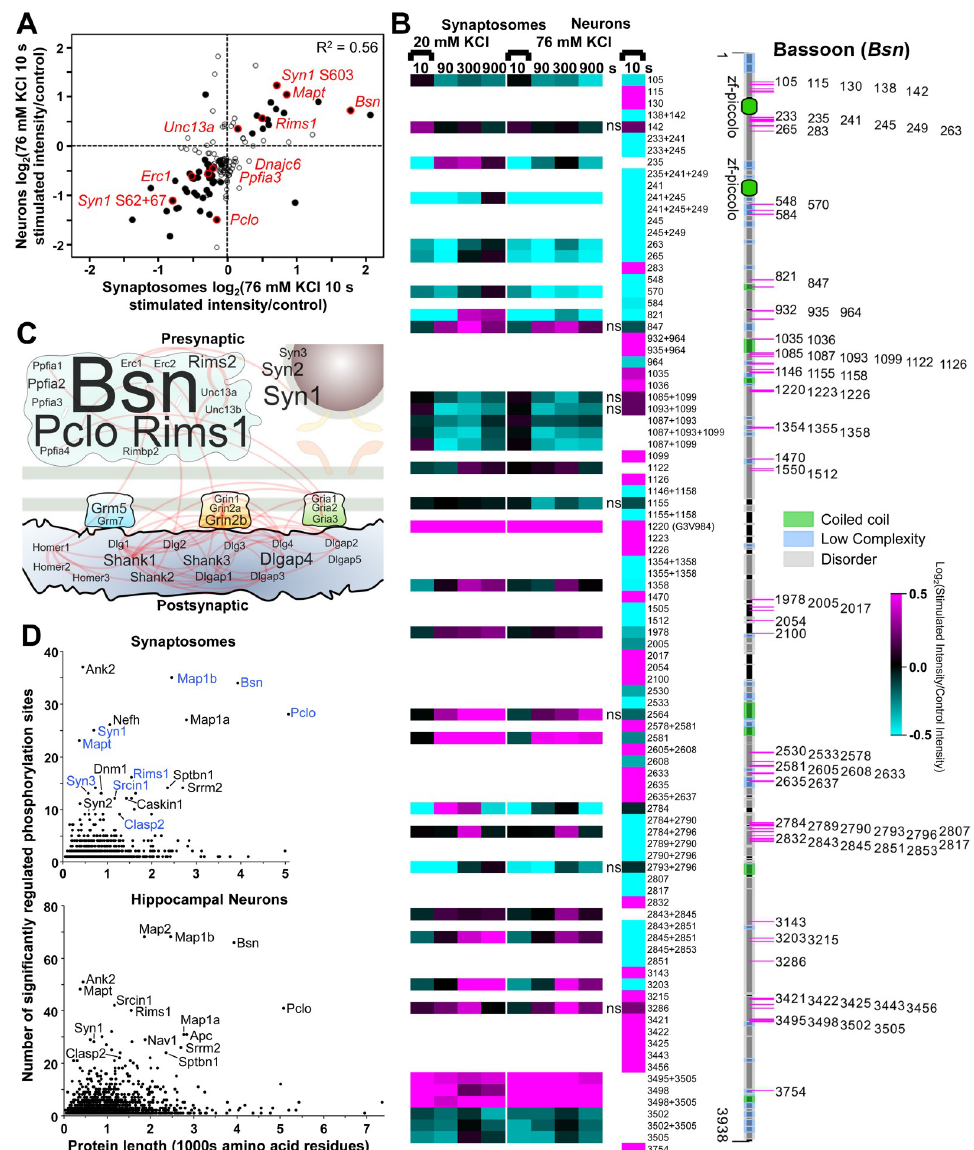
Fig 2. Comparison of activity-dependent changes in synaptosomes and cultured neurons identifies bassoon as a major target of phospho-signalling. (A) Plot of log 2 (76 mM KCl 10-s-stimulated intensity/control intensity) for selected phosphopeptides from cultured hippocampal neurons versus whole-brain synaptosomes. The phosphopeptides compared were required to be from well-established presynaptic proteins. That is, they were exclusively active zone scaffold proteins or synaptic vesicle–associated proteins. Thus, by default, all postsynaptic and ubiquitous proteins were excluded. Solid circles are phosphopeptides significantly regulated in both types of samples. Open circles are phosphopeptides significantly regulated in at least one sample. Selected solid circles have a red outline and are labelled with a gene name. Two specific synapsin 1 phosphorylation sites are featured. Underlying data for this figure can be found in S1 Data. (B) Heat map of bassoon log 2 (stimulated intensity/control intensity) values across time for significantly regulated phosphopeptides from synaptosomes and hippocampal neurons using the indicated colour scale. Note that some log 2 fold changes are outside of the colour scale range. The chosen scale was intended to provide greater emphasis for low-moderate fold changes throughout this work, even though some signals will be saturated. See (A) for an example of the data shown on a larger log 2 scale. The bassoon domain structure of UniProt accession O88778, obtained from Pfam [34], is shown with accurate phosphorylation site positions. Synaptosome data were required to have significant up-/down-regulation at one or more time points. For hippocampal neurons, “ns” means not significantly regulated. Phosphorylation site positions are from bassoon accessions O8878 and G3V984 (see S1 Table). (C) A protein localization and interaction network for selected protein components of the active zone scaffold, synaptic vesicles,